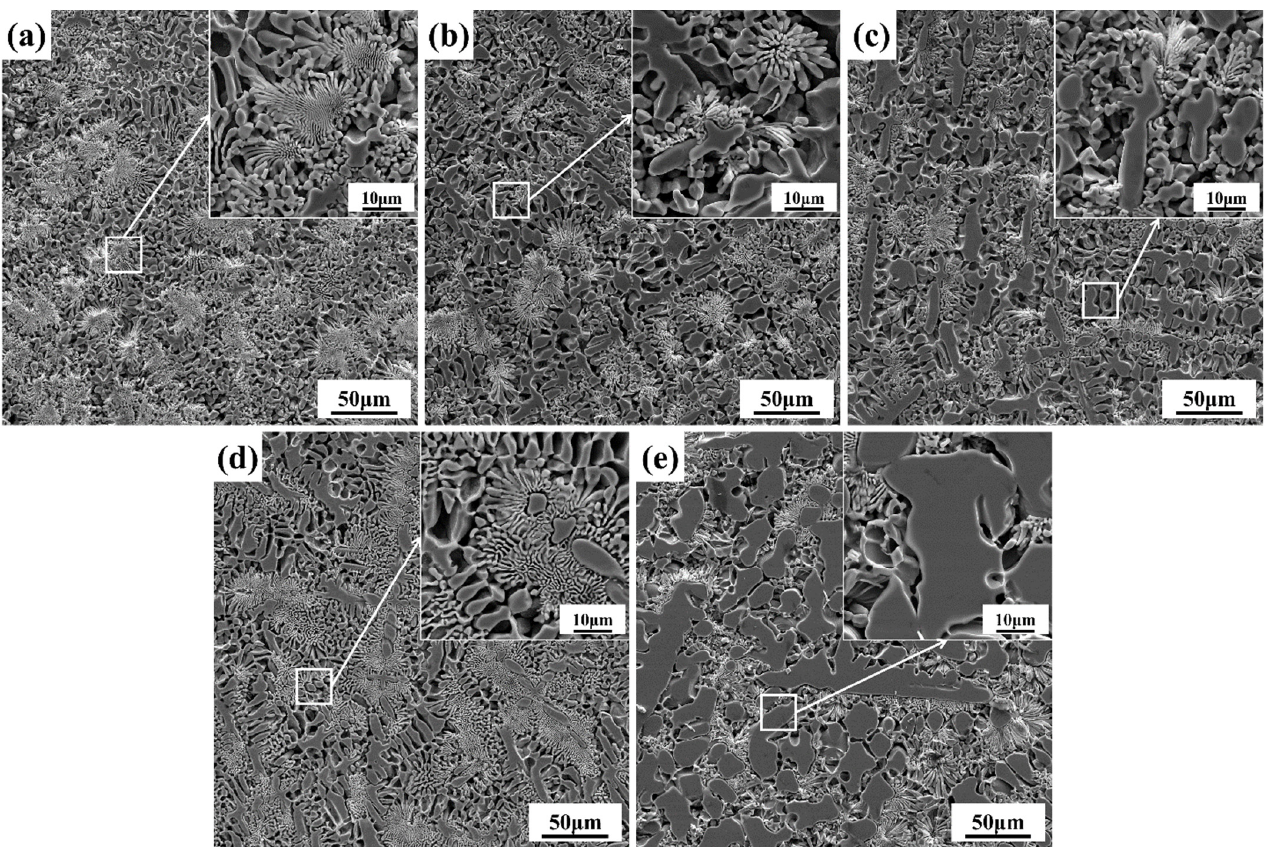
Figure 8. Corrosion microstructures of AlSi 0.5 Cr x Co 0.2 Ni high entropy alloys obtained by SEM; ( a ) x = 1.0, ( b ) x = 1.2, ( c ) x = 1.4, ( d ) x = 1.6, and ( e ) x = 1.8.